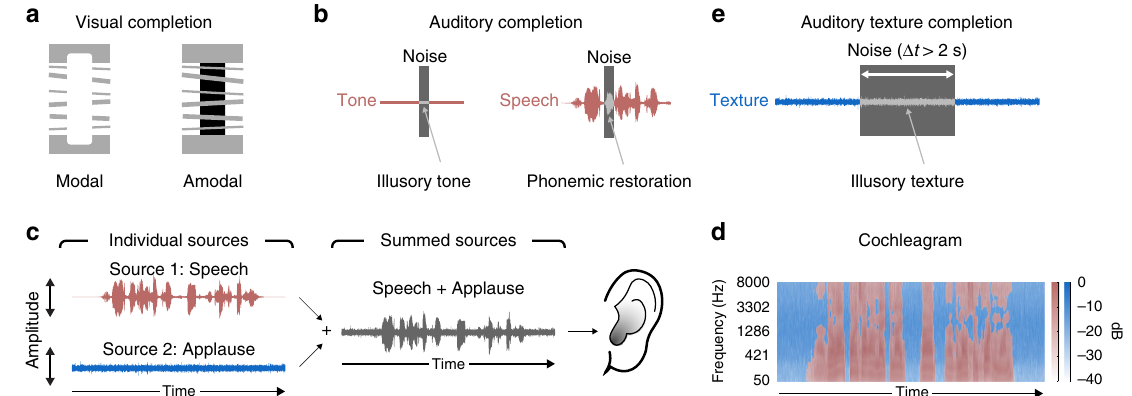
Fig. 1 Perceptual completion effects. a Examples of “ modal ” and “ amodal ” visual completion. In the modal case (left), we see a white rectangle overlaid on gray bars. However, the rectangle edges do not produce contrast where they overlap the background. In the amodal case (right), the black rectangle is seen to continue behind the gray bars. b Traditional examples of auditory completion. Tones can be heard to continue when interrupted with a sound (e.g., noise) suf fi ciently loud as to plausibly mask the tone. The tone is heard to continue even though it is not physically present during the noise. Illusory phonemes (or phonemic restoration) can also occur under similar conditions, when a short segment of speech is replaced with a louder sound. Here and in e, the gray shading of the sound waveform symbolizes illusory sound that is heard despite not being present in the stimulus. c Example auditory scene in which two sound sources (speech and applause) combine to form a single waveform that arrives at the ear. d Masking of background sound texture. The speech sound has more energy during certain time-frequency windows, intermittently masking the background applause sound. The red areas show windows where the speech has more energy than the applause. The blue areas show windows where the applause has more sound energy than the speech. e Illusory texture from auditory texture completion. Illusory texture can be heard when a texture is interrupted with another sound suf fi ciently loud as to mask the texture. The texture is heard to continue even though it is not physically present during the interrupting sound. Texture completion